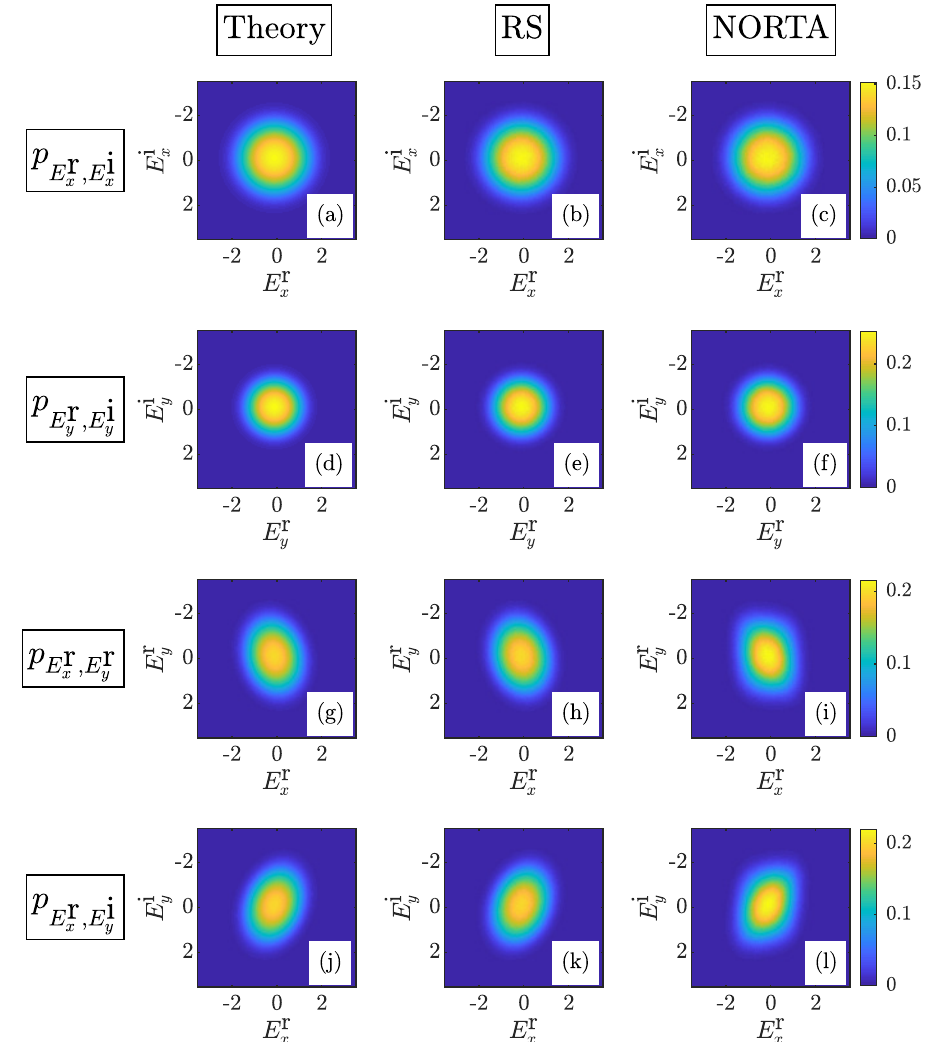
Figure 5. Joint PDFs of E x and E y : ( a – c ) theory, RS, NORTA p E r